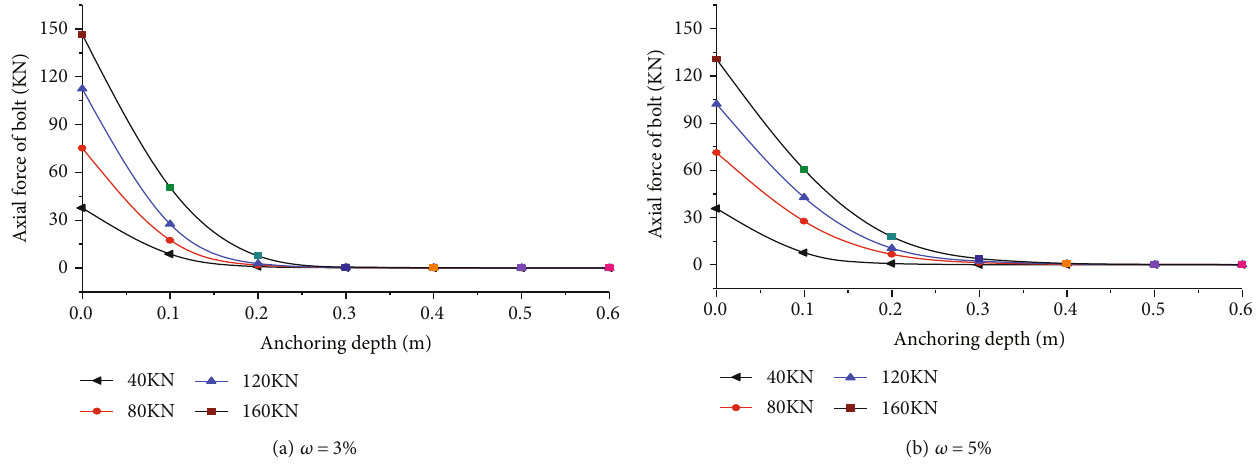
Figure 10: Variation curve of axial force of anchorage